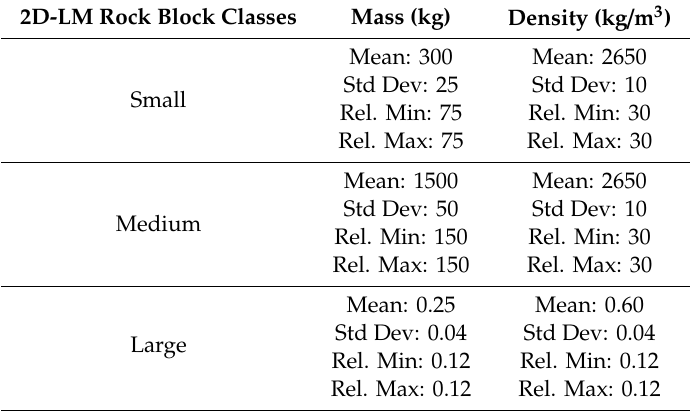
Table 3. Summary of the rock classes defined for the 2D-LM numerical modelling. 2D-LM Rock Block